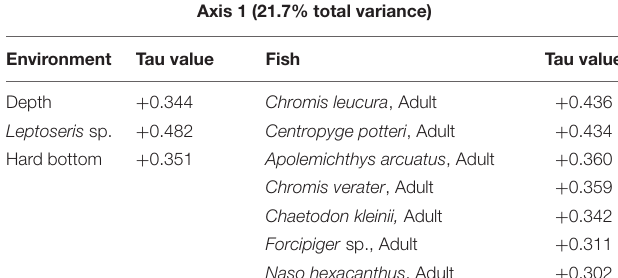
TABLE 2 | Significant Kendall Tau correlations ( P < 0.001) of environmental variables and fish species within the axes-space of Non-metric Multidimensional